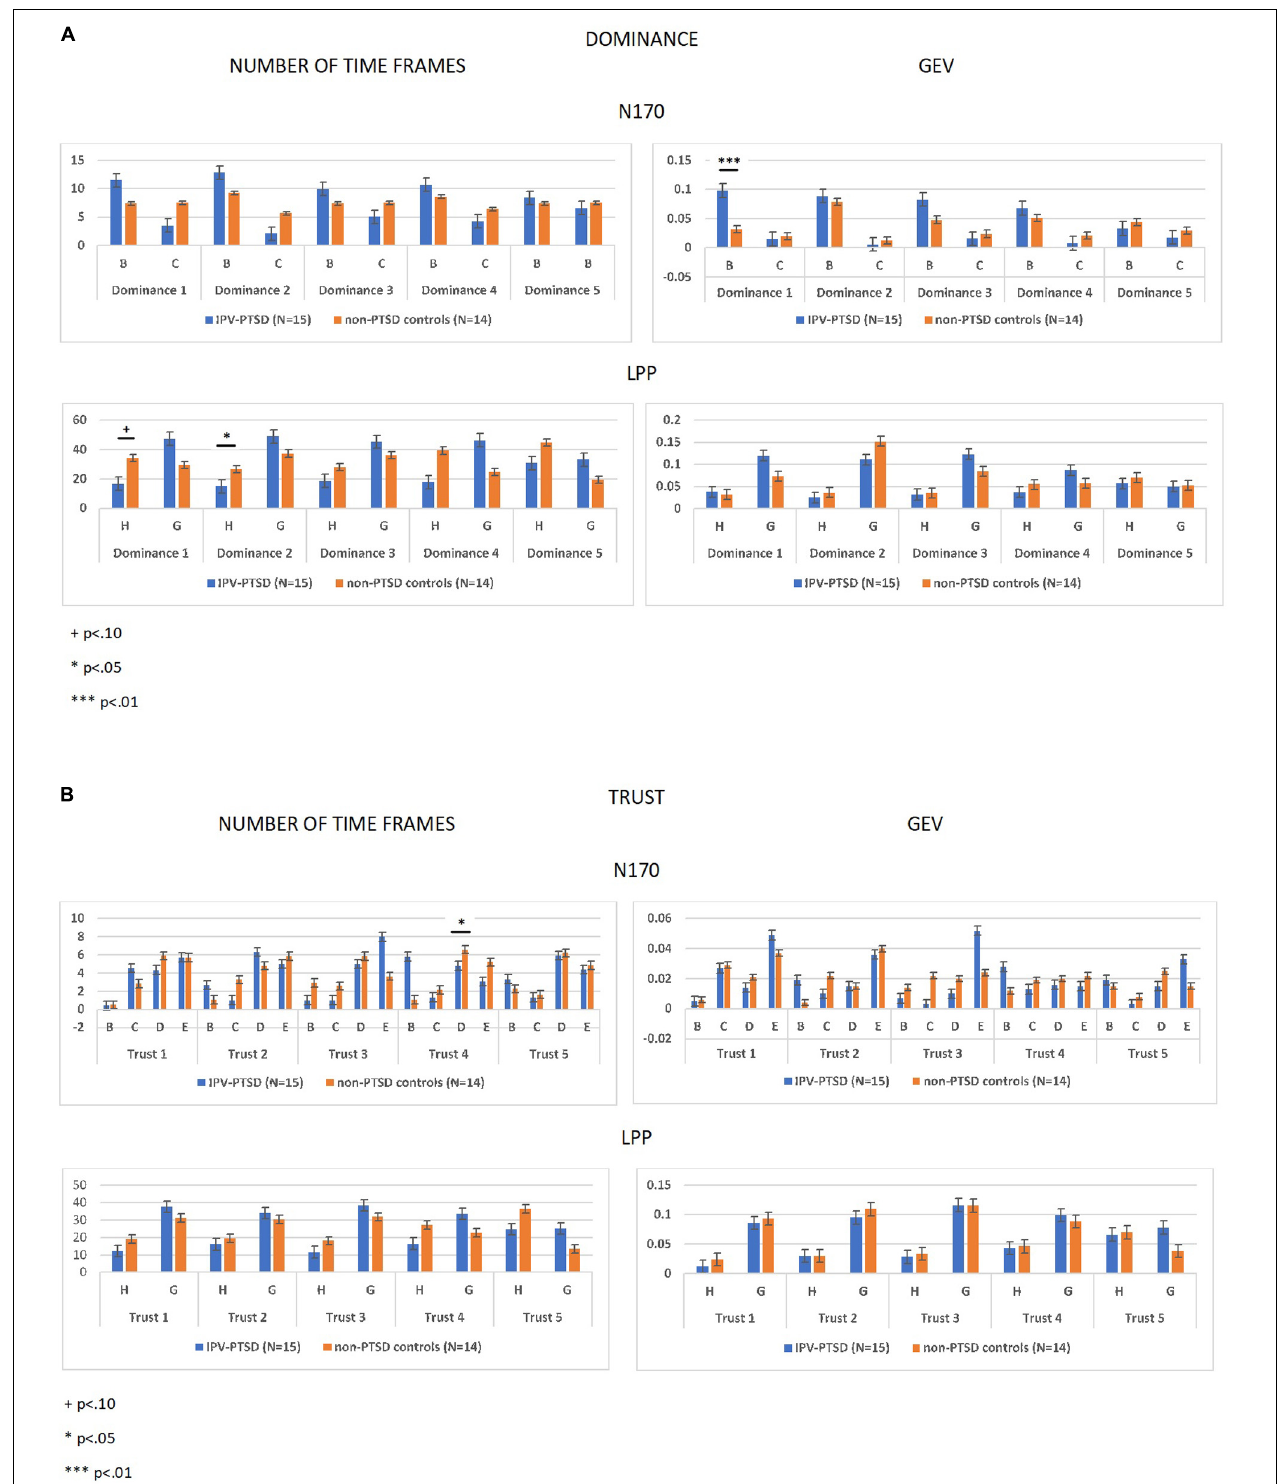
FIGURE 4 | Fitting statistics using independent sample t-tests on number of time-frames and global explained variance (GEV) parameters. Fitting statistics were run on each degree of dominance (Dominance = 1–5) (A) and trustworthiness (Trust = 1–5) (B) dimensions and regarding each group (IPV-PTSD vs non-PTSD controls).